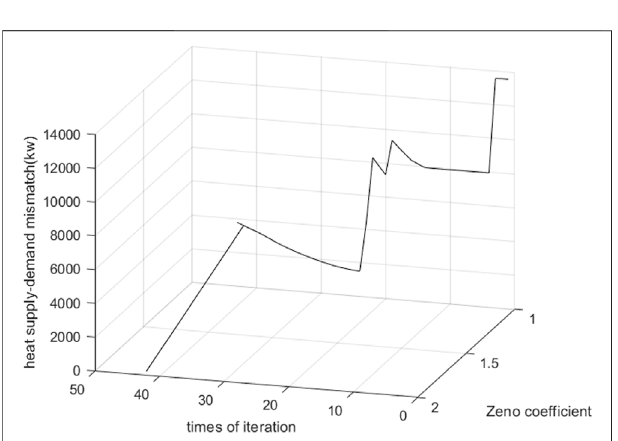
FIGURE 6 | Gas exchanging fl ow (kw).